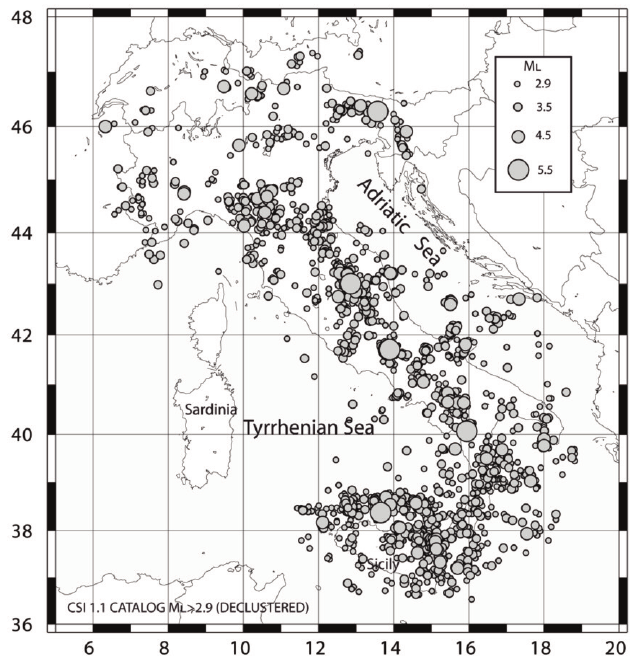
≥ 2.9 earthquakes from the CSI 1.1 L